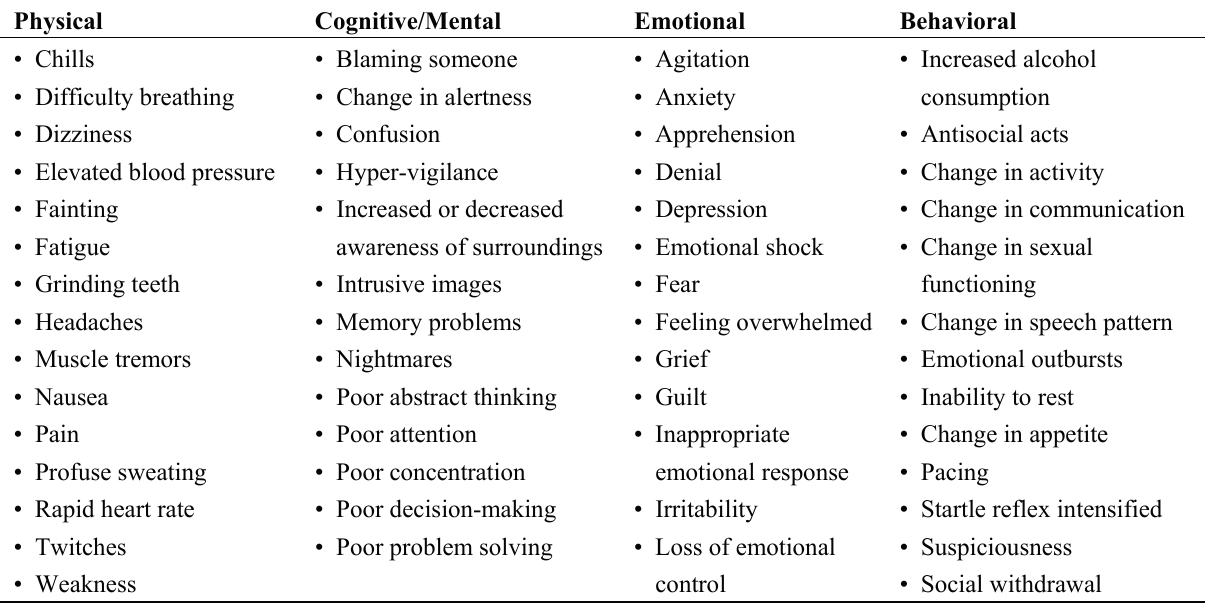
Table 1. Human stress response to acute